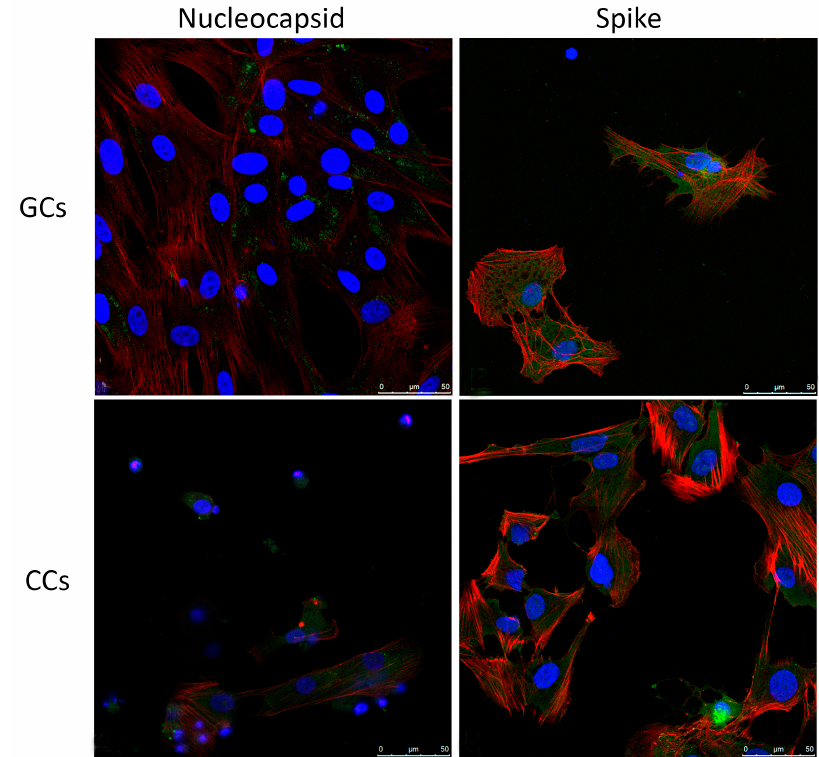
Figure 3. Intracellular localization of SARS-CoV-2 antigens. Representative images of immunoflu- orescence staining of Nucleocapsid and Spike n primary human GCs and CCs. Nucleocapsid and Spike (green), β -Actin (red). Nuclei were counterstained with 4,6-diamino-2-phenylindole (DAPI) (blue). Scale bar = 50 µ m. GCs, n = 15; CCs, n =